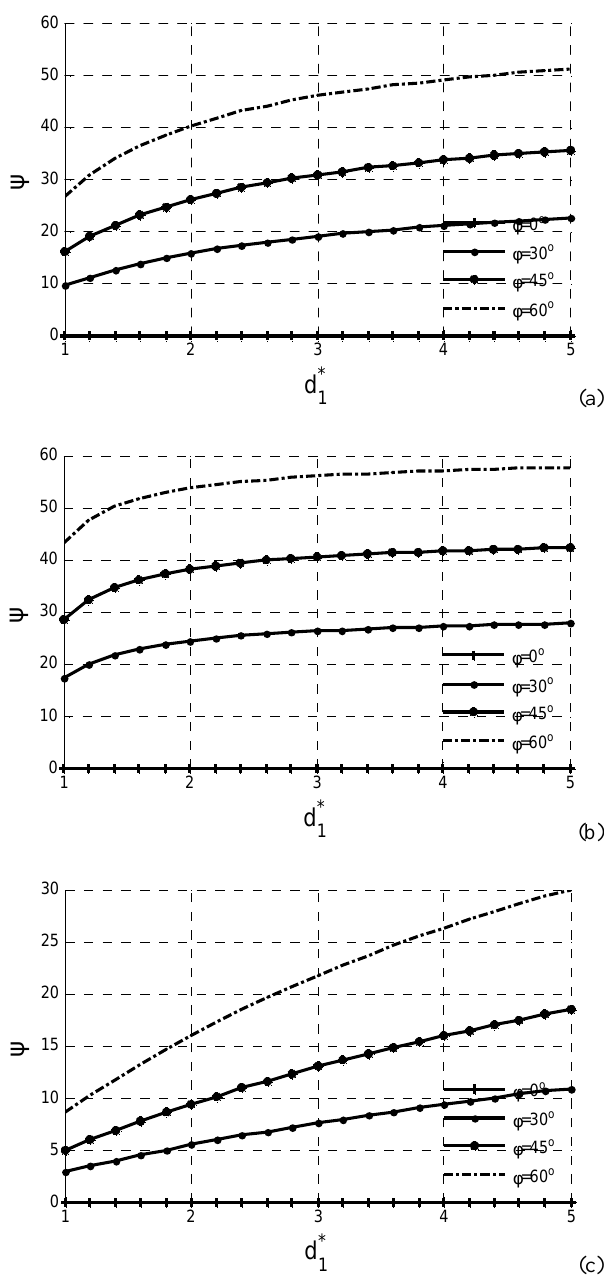
Fig. 6. Flow direction on the weir crest versus water level on the weir crest (a) 1 ∗ (Dimensionless weir height)=0.5, (b) 1 ∗ =2, (c) 1 ∗